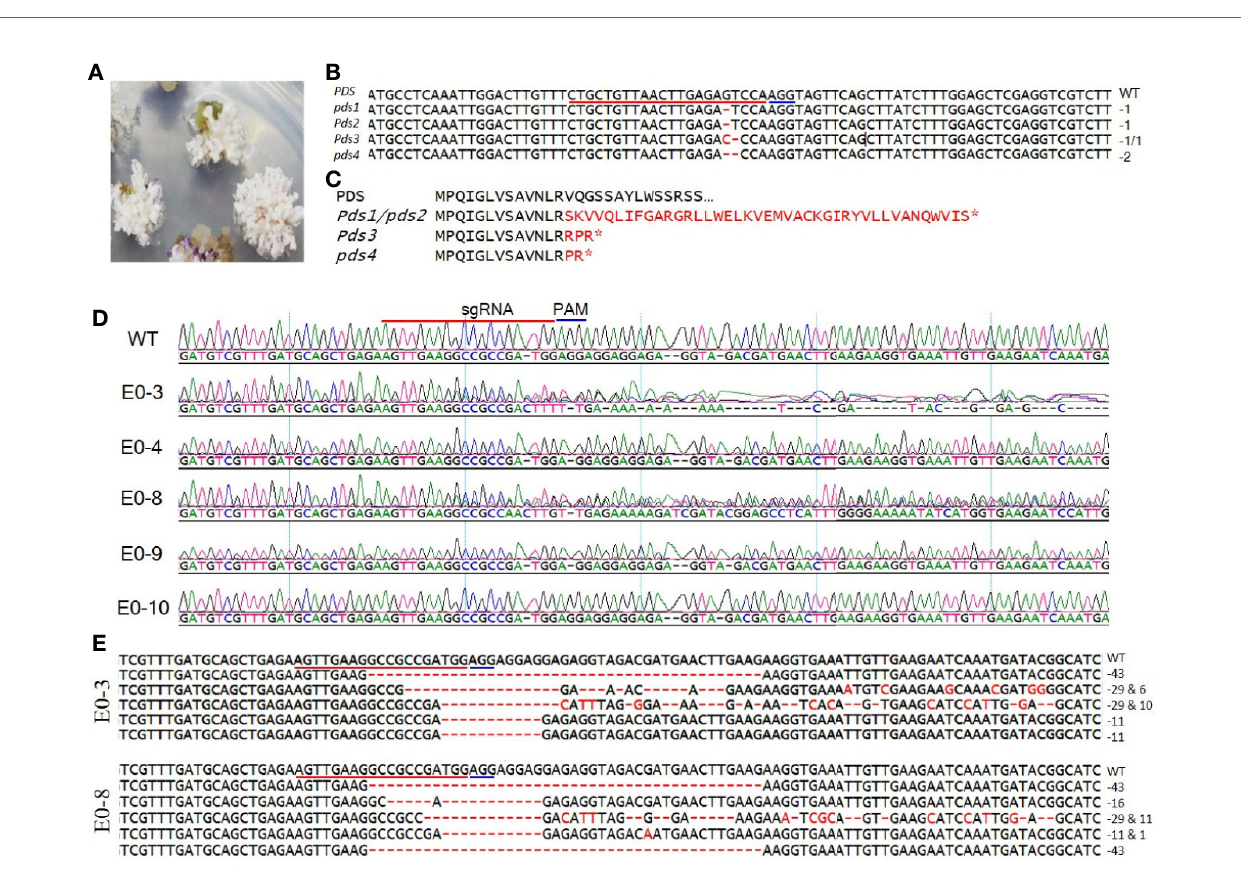
FIGURE 2 | Sequence analysis of the PDS - and eIF4E1 -targeted plants. (A) PDS -targeted explants showing the photobleached phenotype. (B) Mutation detection in PDS -targeted shoots by direct sequencing of PCR product in target region. (C) Predicted amino acid sequence alignment of PDS genes from genome-edited plants. Mutations causing early stop codons or changes in protein sequence are indicated with star symbol. (D) Representative chromatograms produced by direct sequencing of PCR products, displayed for sequence alignment of the mutated eIF4E1 genes from the E0-3, E0-4, E0-8, E0-9, and E0-10 transgenic line. All transgenic lines with exception of the E0-10 showed mixed peaks in the target region due to their varied indels as compared with the wild-type sequence (WT) and are regarded as CRISPR/Cas9-induced mutant lines. (E) DNA sequences of mutated eIF4E1 in the E0-3 and E0-8 line. The number of mutations of each type revealed by random sequencing of TA clones of PCR products. DNA deletions are denoted by red dashes, and deletion sizes (in nucleotides) are marked on the right side of the sequence. The sgRNA target sequence is underlined in red and the PAM motif in